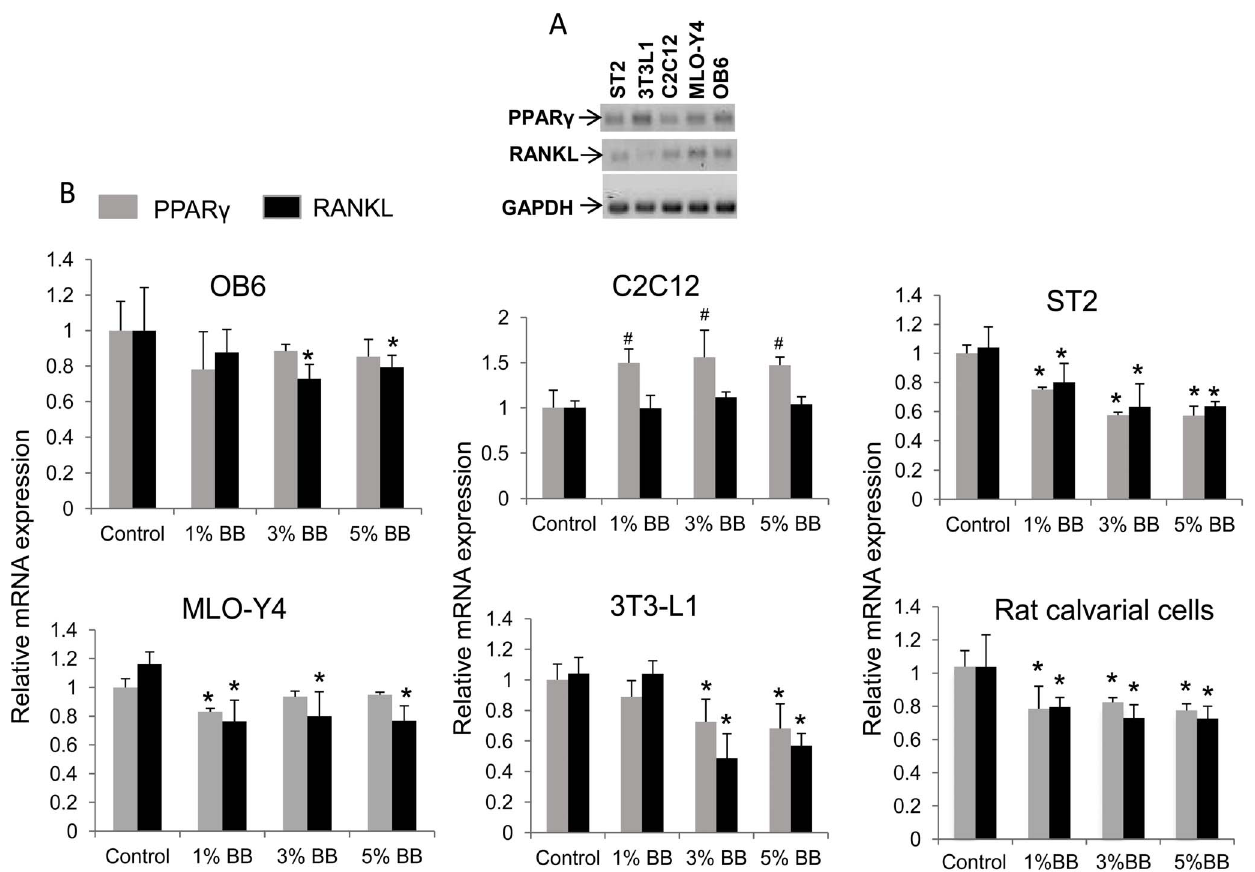
Figure 6. RANKL and PPAR c gene expression in different cell lines after treatment of cells with rat serum. (A) Regular PCR shows endogenous RANKL and PPAR c expression in untreated ST2 cells (bone marrow derived mesenchymal stromal cells), 3T3L1 cells (pre-adipocytes), C2C12 cells (bi-potential stromal cells), MLO-Y4 cells (osteocytic cells) and OB6 cells (mature osteoblasts). (B) Cells were treated with 2.5% rat serum from non-BB or 1, 3, 5% BB diet animals for 24 h. Cell RNA was isolated and real-time PCR was performed for RANKL and PPAR c gene expression. Data are means 6 SEM from triplicate treatment. *, # , p , 0.05 versus control by t test.